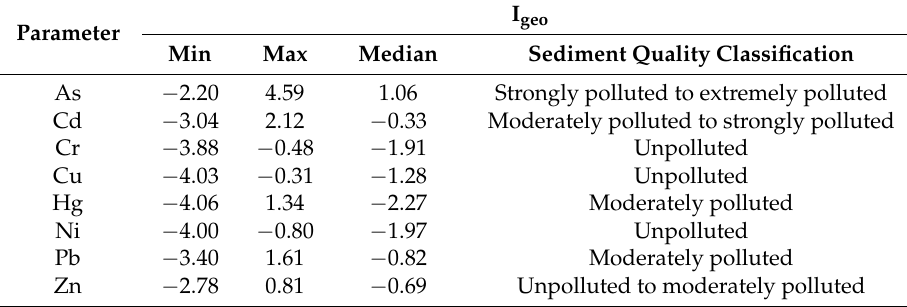
Table 2. Range (min, max) and median value of I geo calculated for trace elements analyzed in sediments of 20 Subalpine reservoirs. Classification follows Barbieri [39] and is referred to maximum